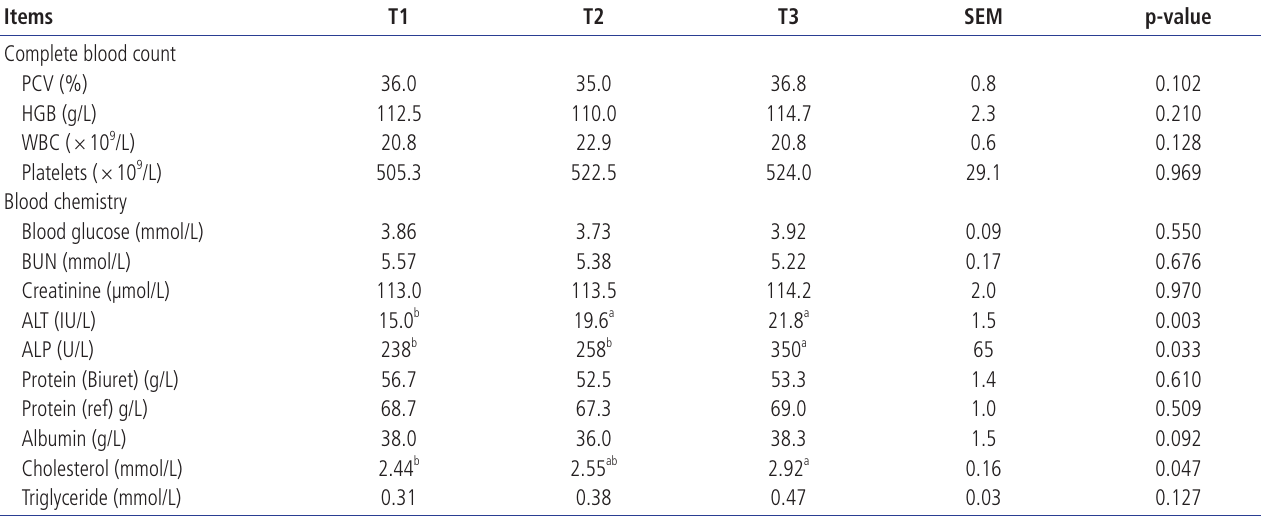
SEM, standard error of mean; PCV, packed cell volume; HGB, hemoglobin; WBC, white blood cell; BUN, blood urea nitrogen; ALT, alanine transminase; ALP, alkaline phos- phatase; ref, refractometer. a,b Means within a row with different superscripts differ